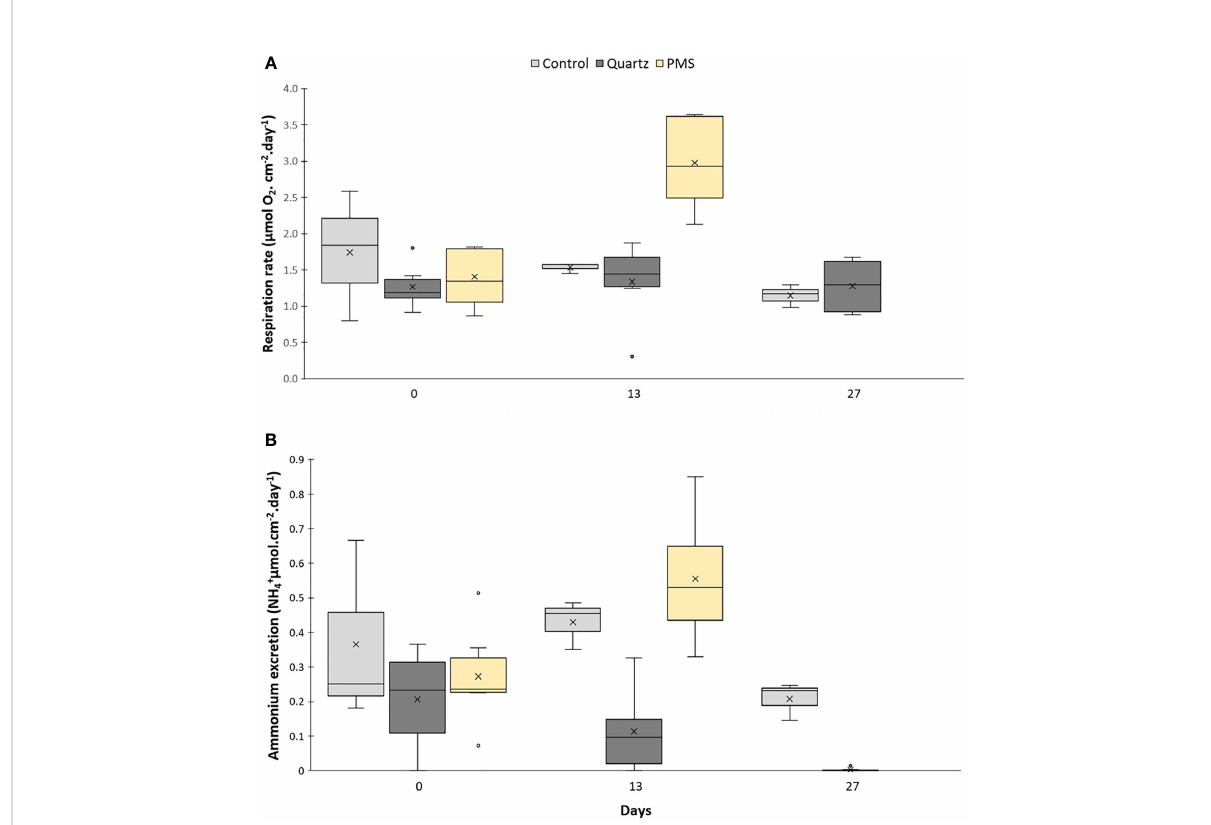
FIGURE 6 Physiological measurements on the cold-water octocoral Dentomuricea aff. meteor . (A) respiration and (B) ammonium excretion rates during the experiment (times 0, 13, 27) in treatments with polymetallic sulphide particles (PMS), with quartz particles (Quartz), and a control treatment with no sediment addition. Data normalized to coral surface area. N=3-6, no fragments in the PMS treatment at time 27 days. The line in the box is the median, and the X is the mean. Whiskers represent the highest and lowest values and outliers are identi fi ed by a circle ( ○